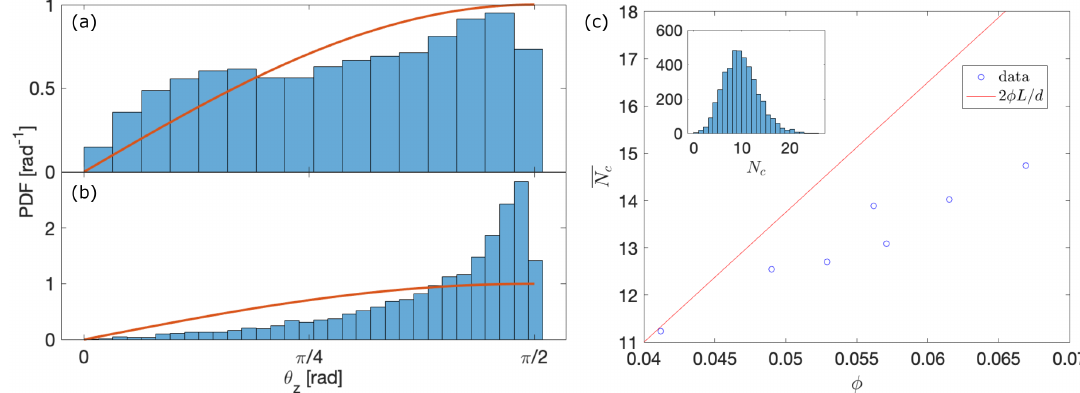
Figure 2. (a-b) Histograms of the angle θ z of a fibre with respect the vertical axis of the column for a sample without pre-compresssion (a) and with 750 g load (b). The red orange curve represents the distribution sin( θ z ) expected for a fully isotropic system. (c) Number of contacts as a function of the packing fraction. The red curve stands for the theoretical prediction N c = 2 φ L / d for an isotropic assembly. The inset show the distribution of number of contacts for a sample without precompression.